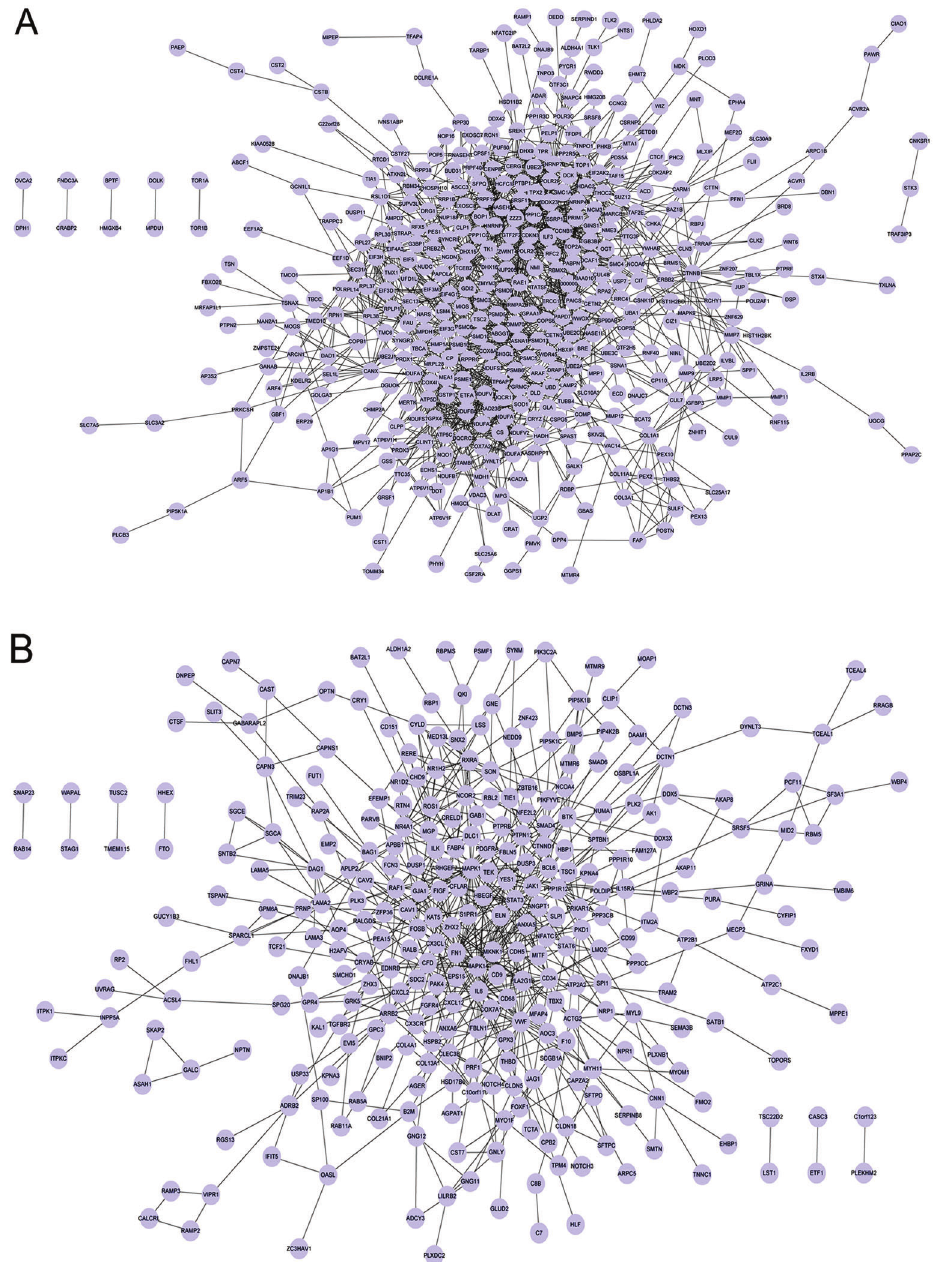
Figure 2. Protein-protein interaction network for upregulated differentially expressed genes ( A ) and downregulated differentially expressed genes ( B